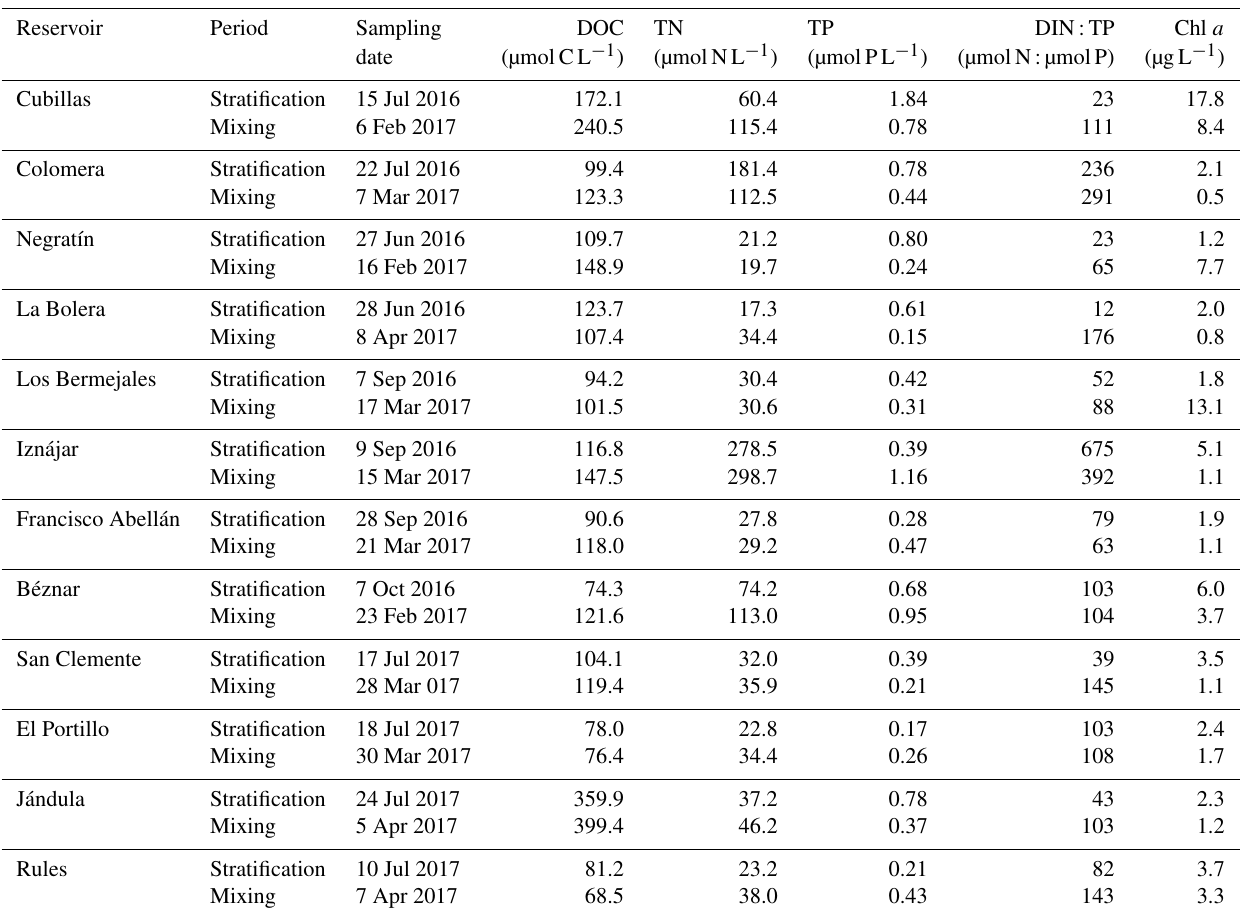
Table 2. Sampling date; mean values of the DOC, TN, and TP concentrations; DIN:TP ratio; and chlorophyll a concentration in the water column of the studied reservoirs during the stratification and the mixing